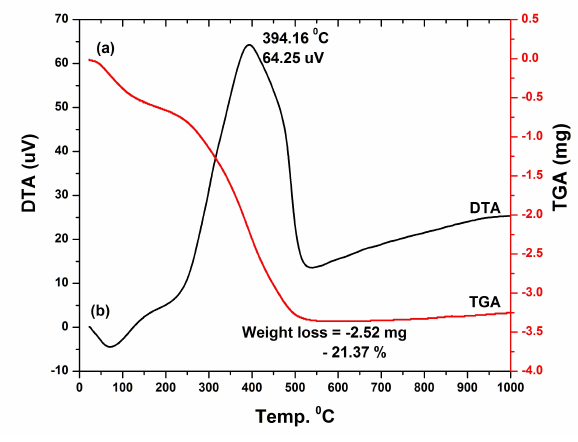
Figure 4: Thermal Analysis result of as synthesized